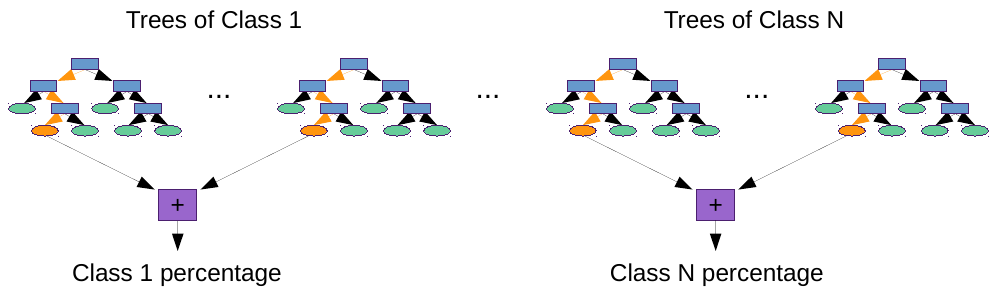
Figure 2. Gradient boosting decision trees (GBDT) results accumulation with one-vs-all